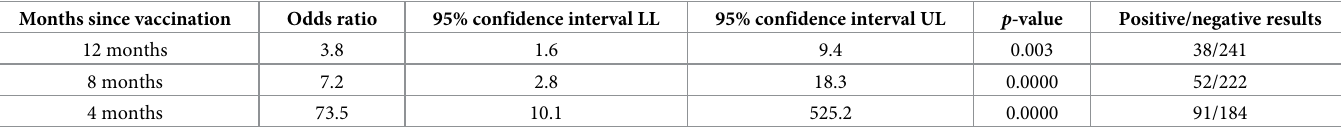
Table 3. Statistical data concerning the level of antibodies to F1 Y . pesti s among people have been vaccinated previously. Months since